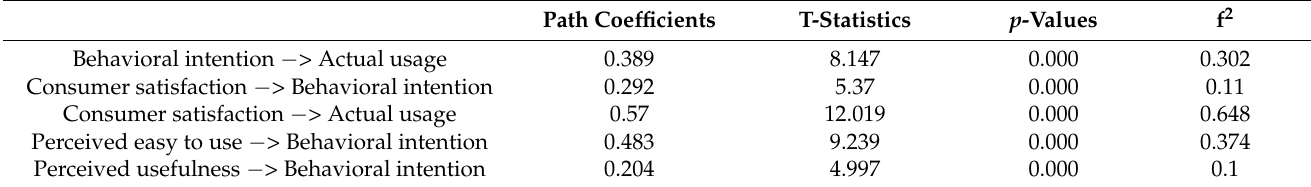
Table 5. Path coefficients and significance in the bootstrapping